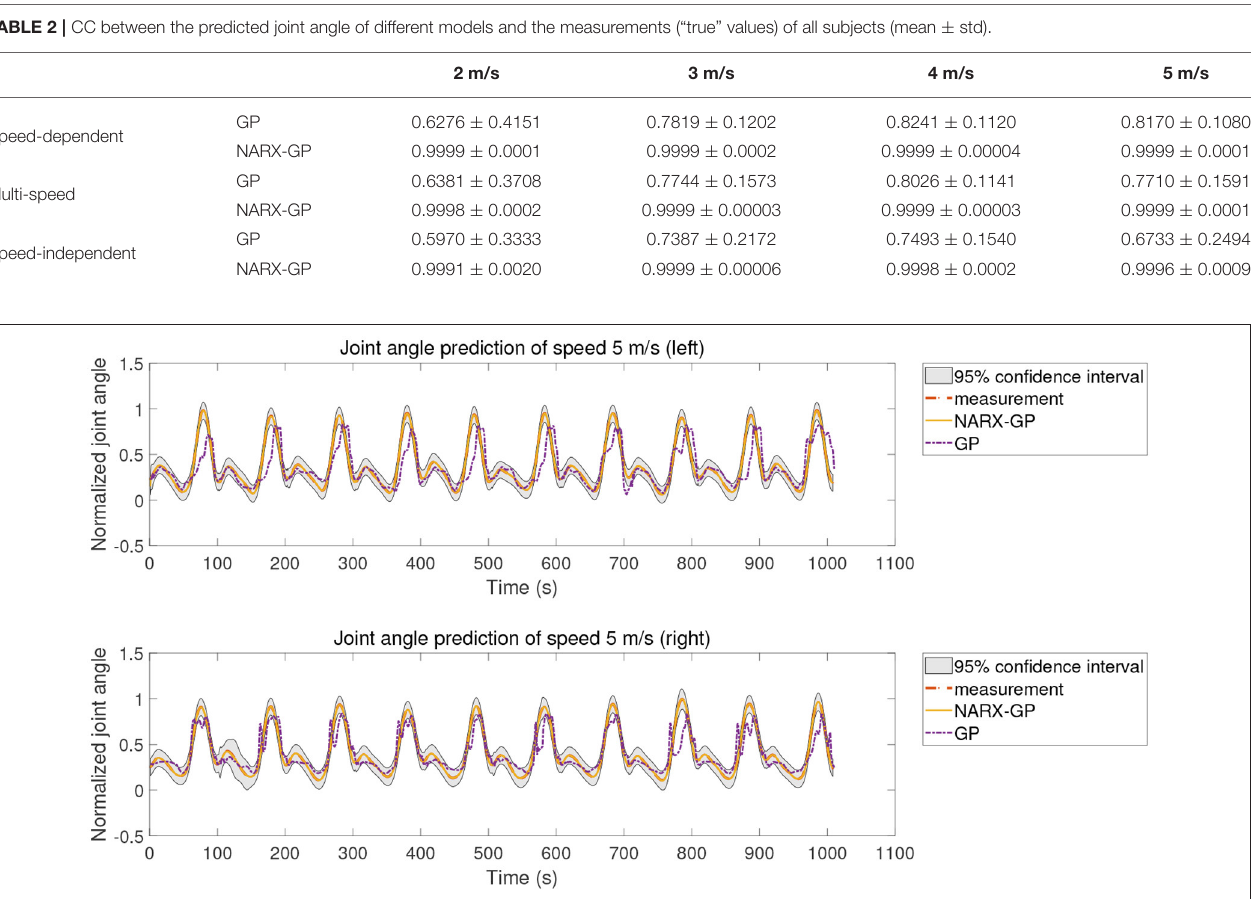
FIGURE 11 | Joint angle prediction of 5 m/s